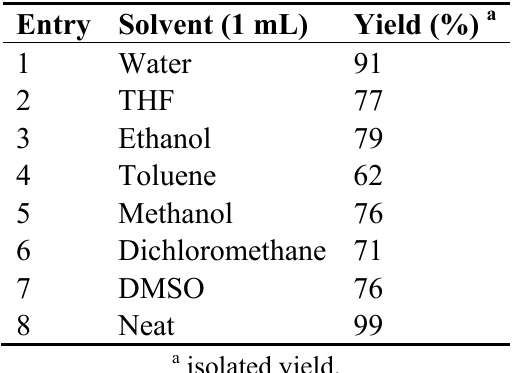
Table 3. Microwave-assisted one-pot, three component synthesis of 1,4-dihydropyridines from benzaldehyde (1 mmol), ethyl acetoacetate (2 mmol) and ammonium acetate (1